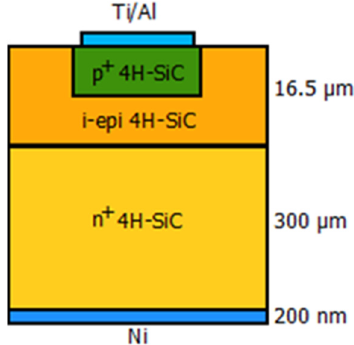
Figure 1. Schematic cross-section of a 4H-SiC photodiode.